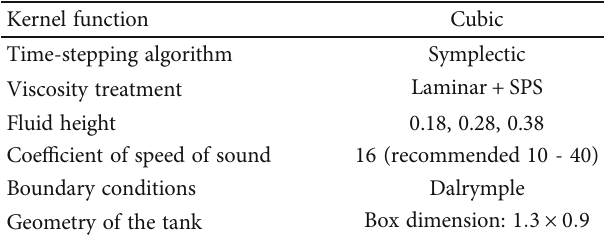
Table 1: The results are based